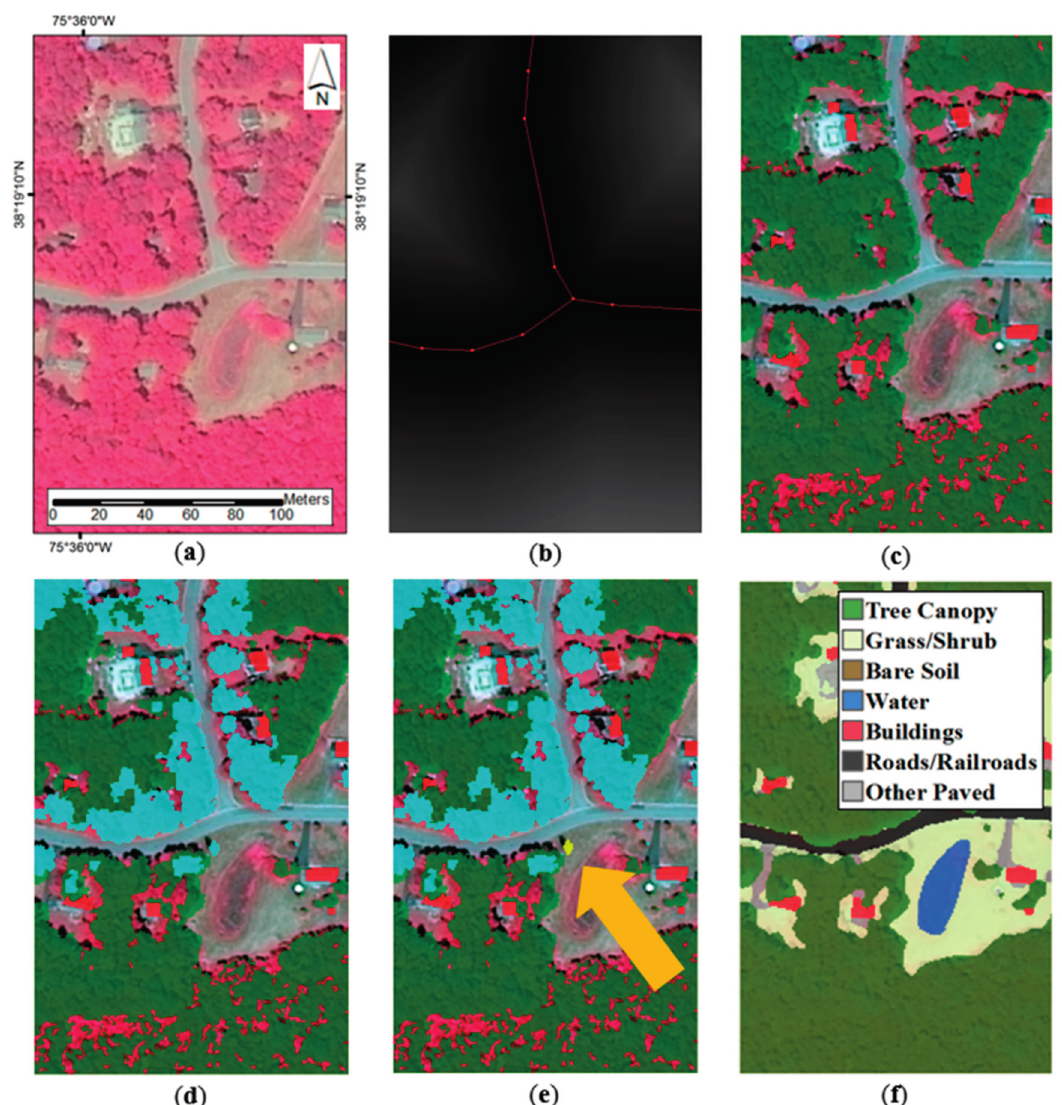
Figure 6. Contextual error-checking of draft tree canopy along roads. ( a ) 1-m GSD 4-band NAIP imagery for Wicomico County, Maryland, USA. ( b ) Thematic road centerlines (red) were used to create a distance-to-roads raster. ( c ) Draft tree canopy (green) was mapped with the nDSM/nDTM segmentation workflow. ( d ) Tree canopy objects were identified by selecting objects within 25 m of roads (blue). ( e ) Erroneous tree canopy was identified by selecting objects with Area <50 m 2 , Maximum Pixel Value >13 m, NDVI < 0.3, and surrounded by ground-level features ( Unclassified ). ( f ) Final 7-class land cover map with erroneous tree canopy assigned to surrounding